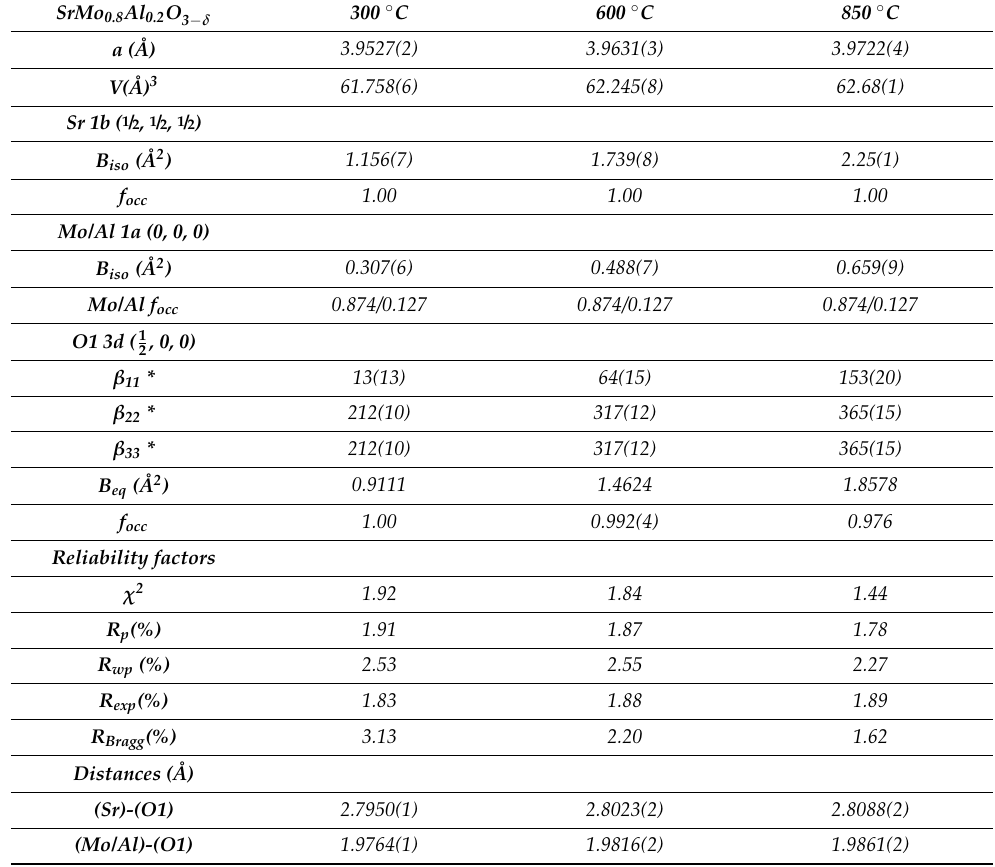
Figure 4. Rietveld plot for the reduced SrMo 0.8 Al 0.2 O 3 − δ perovskite phase. Observed (crosses), calculated (full line) and difference (at the bottom) NPD profiles at 850 °C, refined in the cubic Pm-3m space group. The vertical markers indicate the allowed Bragg reflections. The second series of Bragg reflections correspond to a second perovskite phase with a higher amount of Al. The third series belongs to Sr 8 (Al 12 O 24 )(MoO 4 ) 2 with sodalite structure. Table 2. Unit-cell, thermal parameters, and selected distances (Å) for SrMo 0.8 Al 0.2 O 3 − δ (major perovskite phase) refined in the cubic Pm-3m (no. 221) space group, from NPD from 300 to 850 ° C.